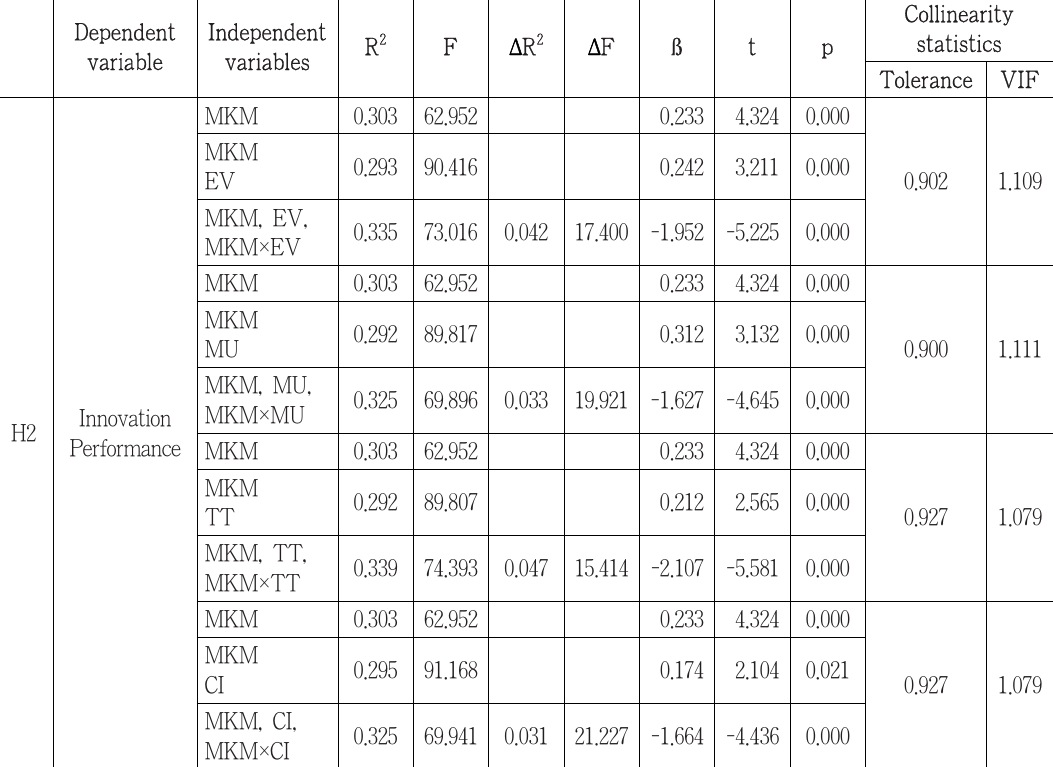
<Table 5> Results of the regression analysis about the moderating